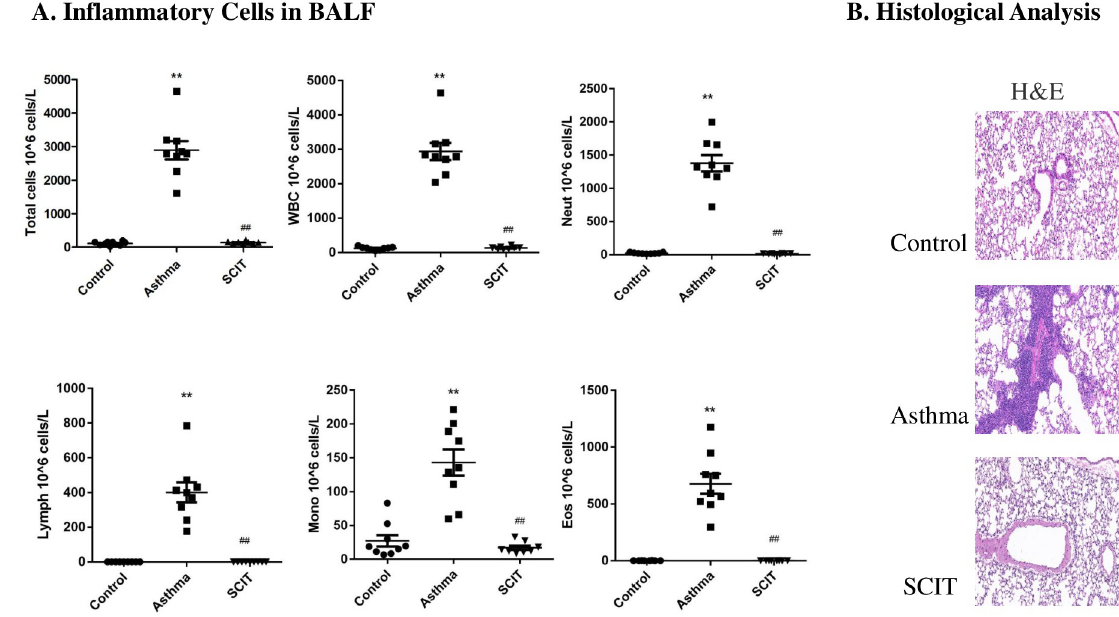
Fig 2. SCIT therapy reduces inflammatory responses in the lungs of birch pollen induced allergic mice. A. Inflammatory cells in BALF. Total cells; WBC, white blood cell; Neut, neutrophils; Lymph, lymphocytes; Mono, monocytes; Eos, eosinophils. �� represented the asthma group vs. the control group, P < 0.01; ## represented the asthma group vs. the SCIT group, P < 0.01. B. Histological Analysis: Lung specimens were stained with H&E staining. Inflammation scores were shown as